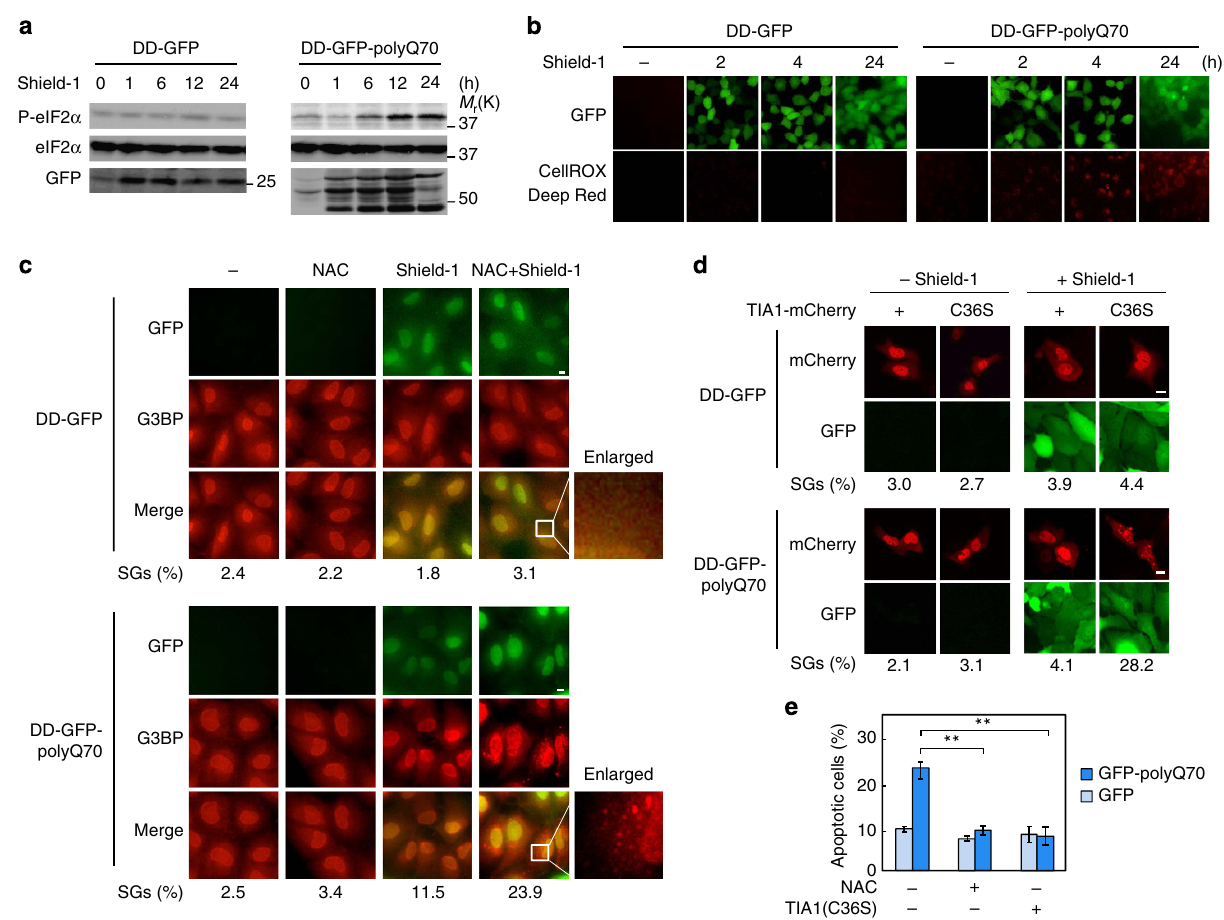
Figure 4 | TIA1(C36S) promotes SG formation and suppresses apoptosis in polyQ70-expressing cells. ( a ) U2OS cells stably expressing DD-GFP or DD-GFP-polyQ70 were exposed to 1 m M Shield-1 for the indicated times. Phosphorylated (top) and total (middle) eIF2 a in cell lysates were assessed in immunoblotting with specific antibodies. Expression of GFP or GFP-polyQ70 was determined by immunoblotting with an anti-GFP antibody (bottom rows). ( b ) U2OS cells stably expressing DD-GFP or DD-GFP-polyQ70 were exposed to Shield-1 for 2, 4 or 24h. ROS production was visualized by fluorescence microscopy using the CellROX Deep Red reagent. ( c ) U2OS cells stably expressing DD-GFP (upper panels) or DD-GFP-polyQ70 (lower panels) were treated with NAC, Shield-1 or with both simultaneously as indicated and were incubated for 24h. GFP expression was detected by fluorescence and endogenous G3BP was visualized by immunofluorescence using anti-G3BP antibody. The percentage of the cells containing SGs was determined and is shown below. ( d ) U2OS cells expressing DD-GFP or DD-GFP-polyQ70 were transfected with mCherry-fusion TIA1 as indicated. Cells were incubated for 24h and exposed to Shield-1 for 24h. GFP (green) and mCherry (red) fusion proteins were detected by fluorescence. The percentage of mCherry- expressing cells that contained SGs was determined. ( e ) HEK293 cells transfected with GFP or GFP-polyQ70 were co-transfected with or without TIA1(C36S) as indicated. Twenty four hours after transfection, the medium was replaced with fresh media, with or without NAC, and the cells were incubated for another 4 days. Apoptosis of GFP-positive cells was assessed by Annexin V staining. Error bars indicate s.e.m. ( n ¼ 3). ** P o 0.01, Student’s t -test. Scale bars, 10 m